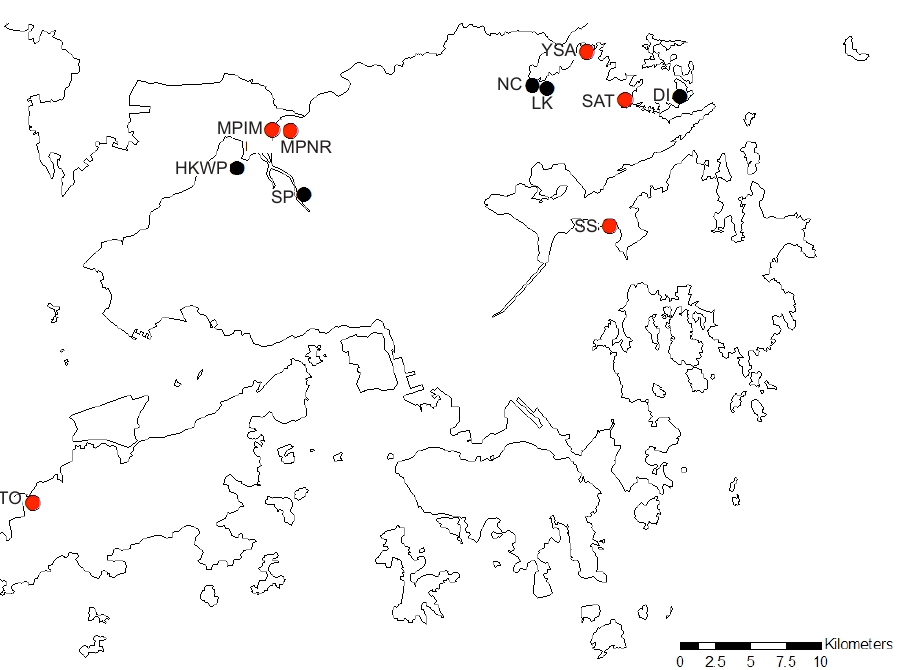
Figure 2. Distribution of Mortonagrion hirosei in Hong Kong. MPNR - Mai Po Marshes Nature Reserve; MPIM - Mai Po Marshes Intertidal Mangrove; SAT - Sam A Tsuen; SS - Sai Sha; TO - Tai O; YSA - Yung Shue Au; DI - Double Island; HKWP - Hong Kong Wetland Park; SP - Sha Po; LK - Luk Keng; NC - Nam Chung. Sites marked in red were surveyed as part of this